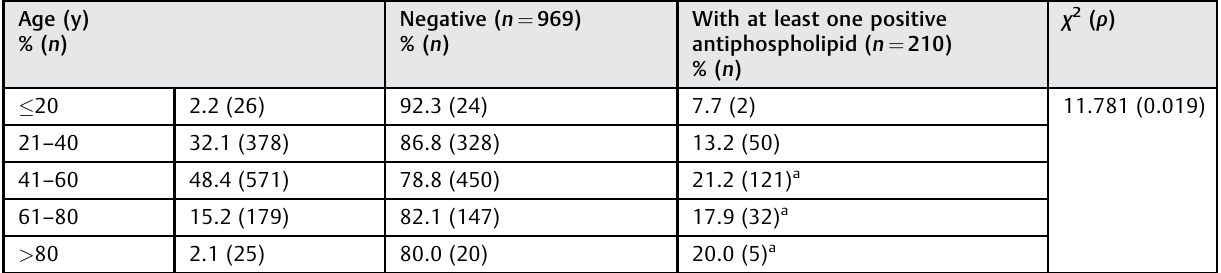
Table 4 Positivity prevalence by age